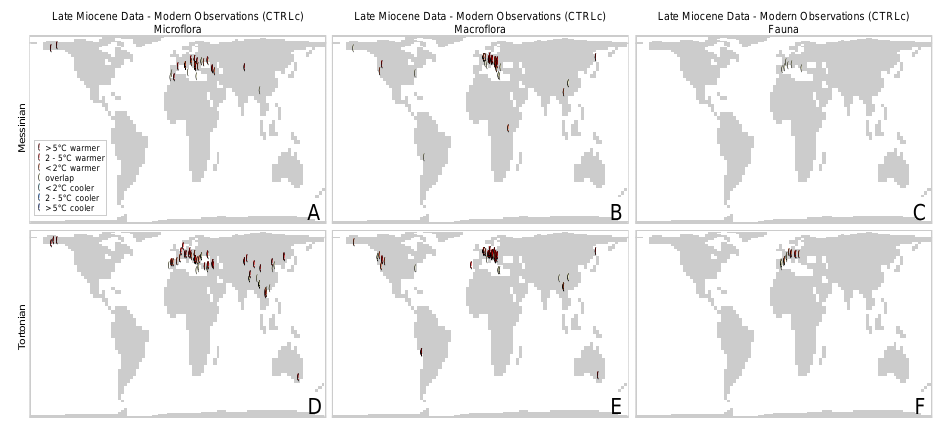
Fig. 7. Results from the model–data comparison for mean annual temperature, late Miocene data–modern potential natural climate estimates.